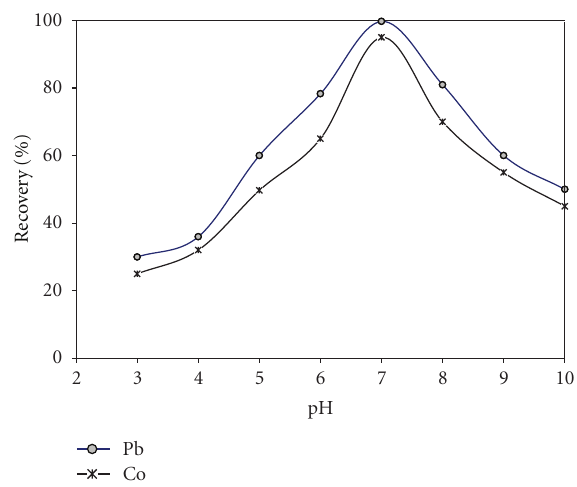
Figure 1: E ff ect of pH on the percentage of recovery: 20 µ gL − 1 of Pb and Co, 5 . 0 × 10 − 3 molL − 1 oxine, 0.5% (v/v) Triton X-114, temperature 50 ◦ C, and centrifugation time 10 min (3500rpm).